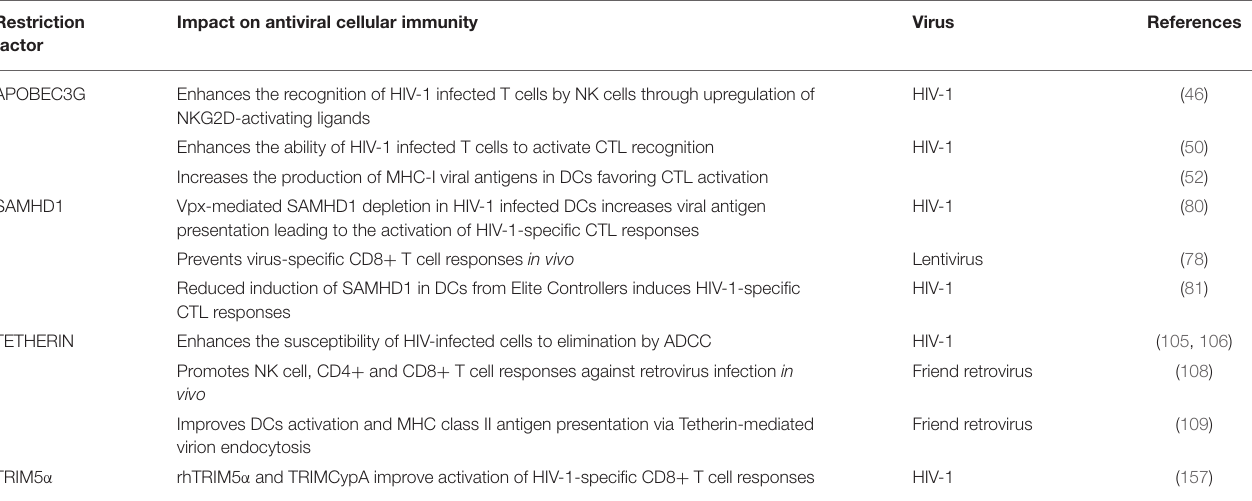
TABLE 1 | Restriction factors and their impact on antiviral cellular immunity. Restriction